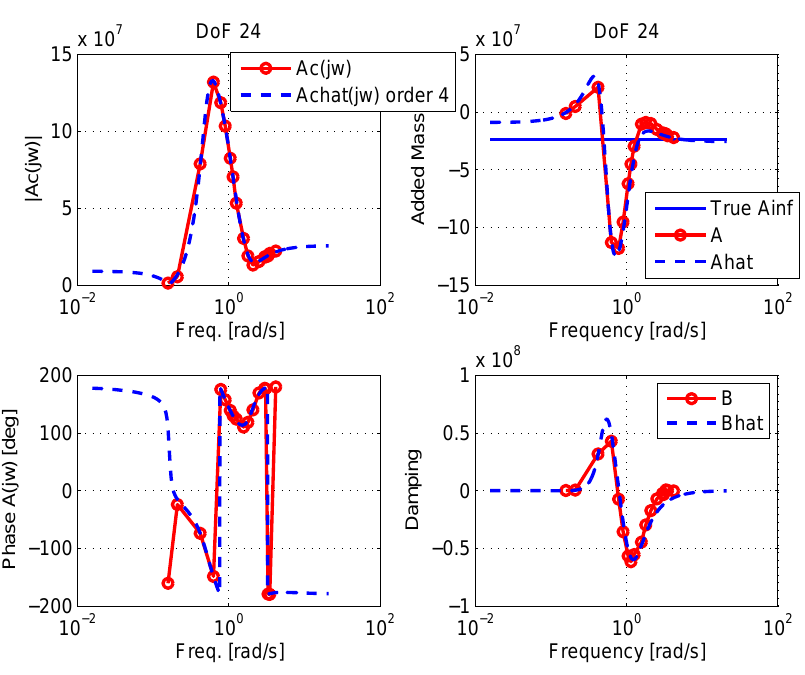
Figure 3: Fitting results for the FPSO. Left column: Frequency response ˜ A 24 ( jω ) and estimate. Right column: Reconstruction of added mass and damping from the identified fluid memory function ˆ K 24 ( jω ) based on an 6th order approximation.